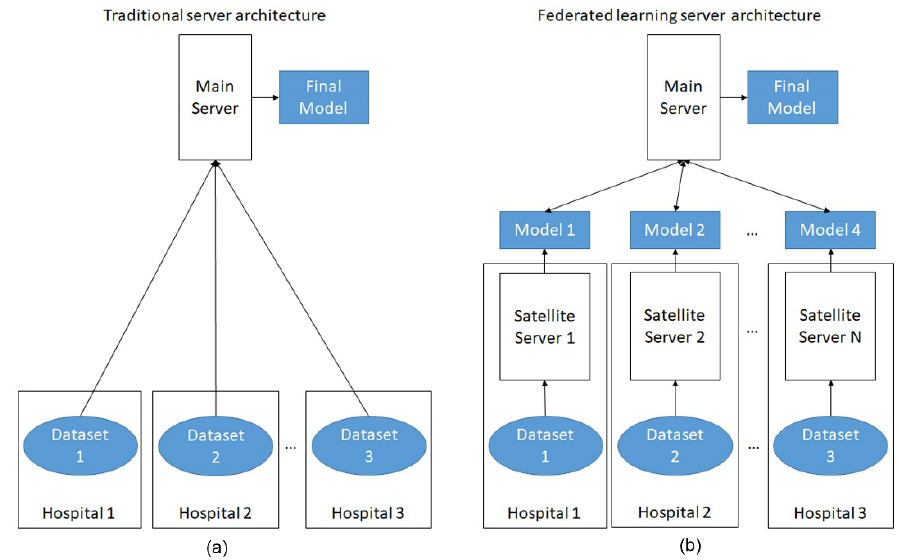
Figure 3. The comparison of traditional AI server architecture and federated learning server archi- tecture. ( a ) In traditional server architecture, the main server processes all the raw data at the same site, leading to concerns about privacy; ( b ) In federated learning, the datasets are processed at each individual site and only the trained models are shared with the main server. Privacy of each dataset is protected.